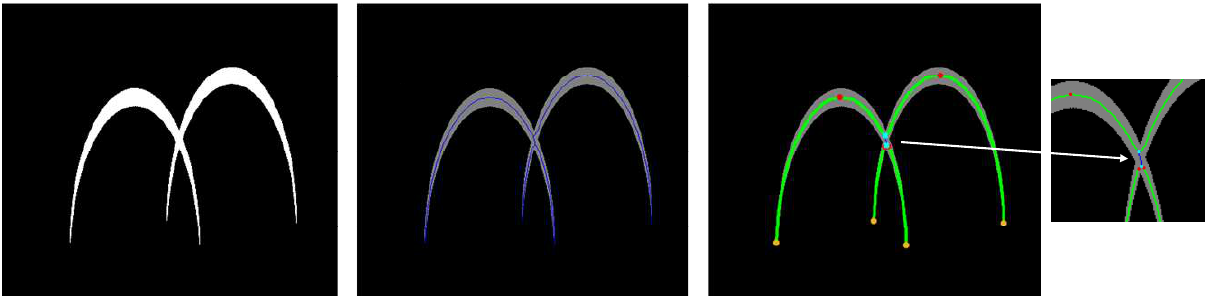
Figure 11 . Binarized image (left), skeletonized hyperbolas (middle) and splitting overlapping hyperbolas